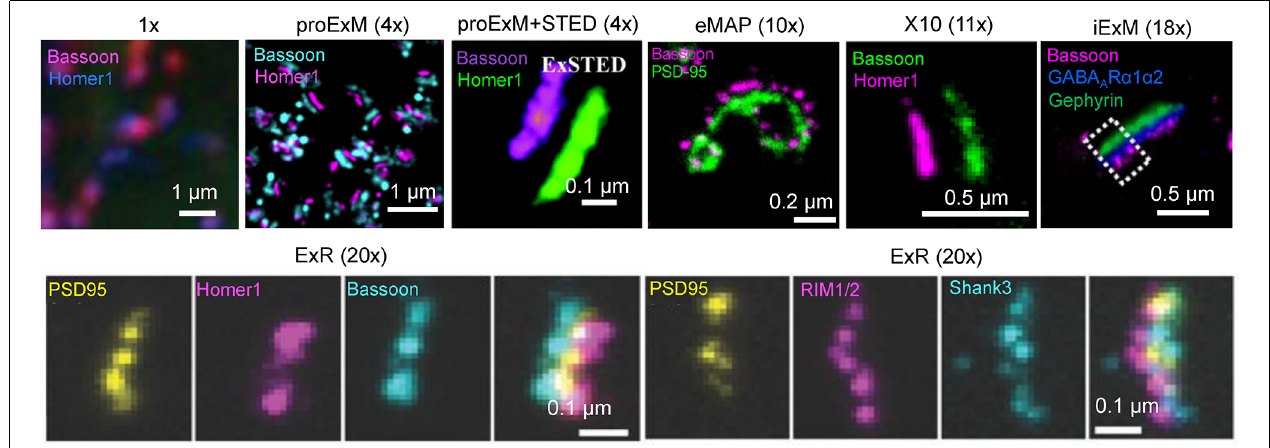
FIGURE 2 | Visualization of synapses in mouse brain tissue using different ExM protocol modifications. The values in parenthesis represent the linear expansion factor for the corresponding image. Adapted from Chen F. et al. (2015), Chang et al. (2017), Li et al. (2018), Truckenbrodt et al. (2018), Gao R. et al. (2019), Sarkar et al. (2020), and Park et al.